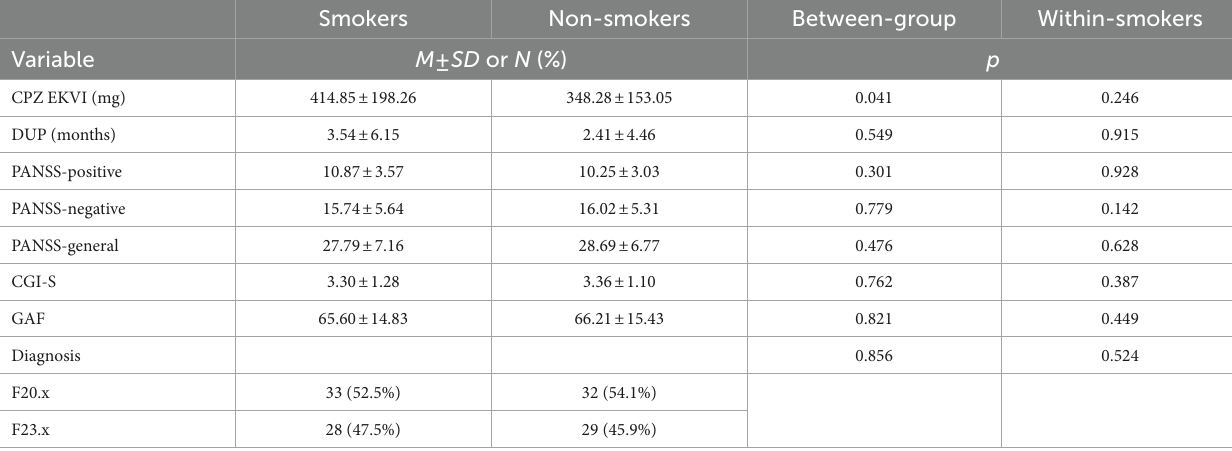
TABLE 1 Clinical characteristics in smokers ( N = 61) and non-smokers ( N = 61) with recent-onset SSDs, and their relationship to cigarette smoking status and